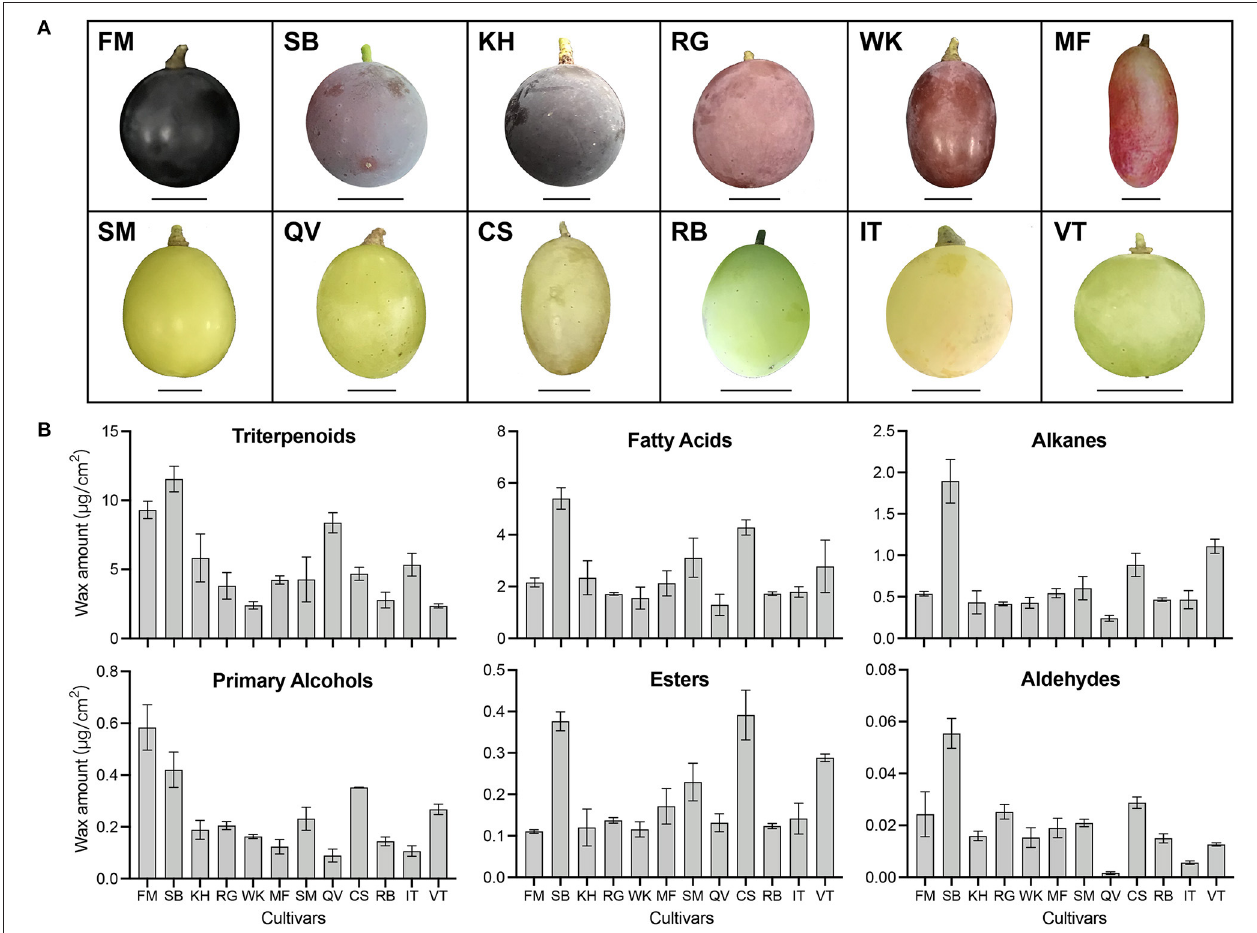
FIGURE 3 | Berry morphology (A) and wax amount (B) in twelve grape cultivars. Twelve grape cultivars: KH, “Kyoho”; RG, “Red Globe”; SM, “Shine Muscat”; FM, “Fujiminori”; SB, “Summer Black”; WK, “Wink”; MF, “Manicure Finger”; QV, “Queen of Vineyard”; CS, “Centennial Seedless”; RB, “Rosario Bianco”; IT, “Italia”; VT, “Victoria”. Scale bars represent 1cm. Error bars indicate SD from three biological